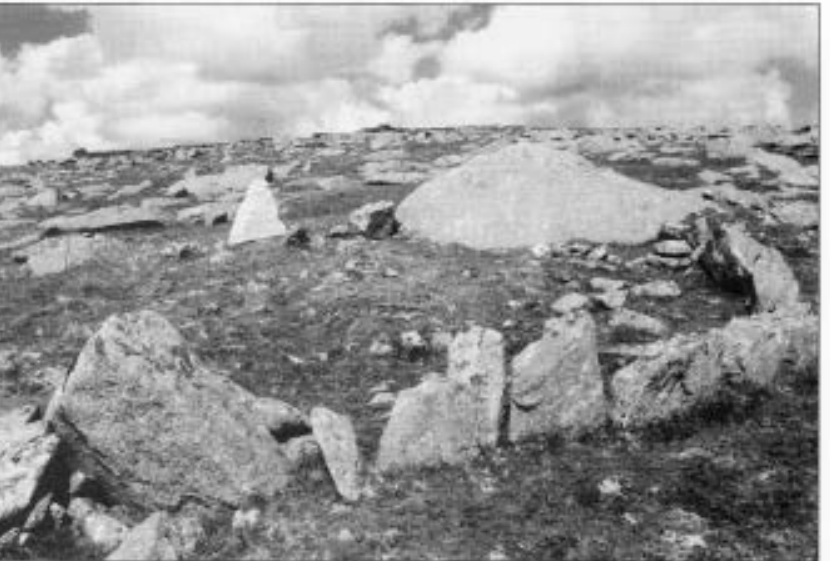
Figure 6 Exterior walls of house 20 at Leskernick with prominent whale-shape back­ stone opposite the entrance, and triangular stone wrapped in cling film and